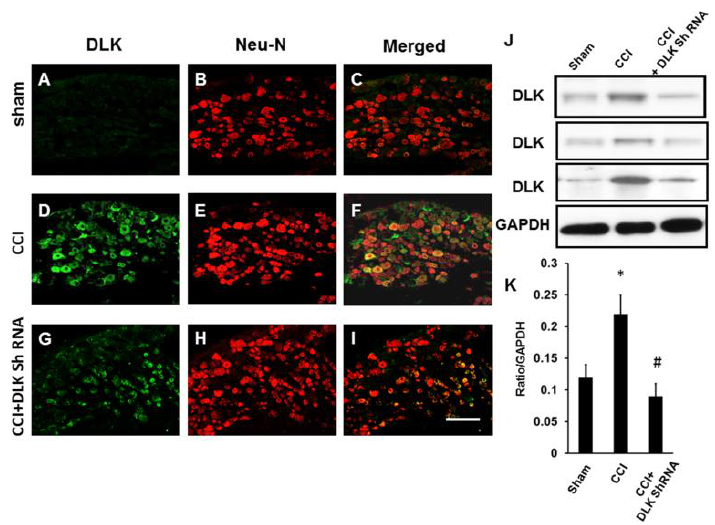
Figure 7. Illustration of DLK in dorsal root ganglion cells in CCI animals subjected to intrathecal injection of DLK shRNA. ( A ) Expression of DLK in dorsal root ganglion cells in the sham group. ( B ) Co-localization with Neu-N. ( C ) Merged imaging of ( A , B ). ( D ) Expression of DLK in dorsal root ganglion cells in the four rings CCI group. ( E ) Co-localization with Neu-N. ( F ) Merged imaging of ( D , E ). ( G ) Expression of DLK in dorsal root ganglion cells in the four rings CCI group treated by intrathecal administration of shRNA of DLK. ( H ) Co-localization with Neu-N. ( I ) Merged of ( G , H ). ( J ) Illustration of Western blot imaging. ( K ) Quantitative analysis of Western blot analysis. * p < 0.05 indicated four rings CCI relative to sham; # p < 0.05 indicated the shRNA of DLK relative to four rings CCI group. Bar length = 200 μ m.